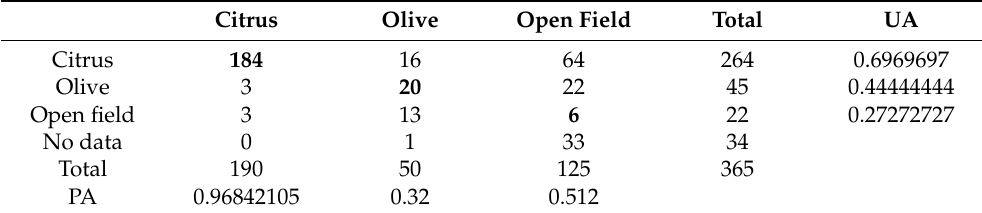
Table 5. Confusion matrix of the classification with NDVI + VV + VH as the input feature performed by M6. Citrus